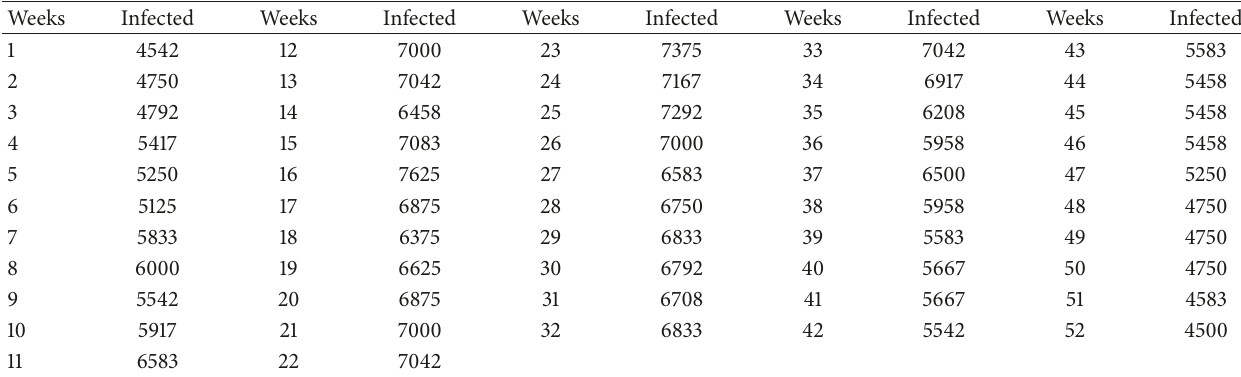
Table 2: Weekly dysentery diarrhea reports in Ethiopia, 2017 .